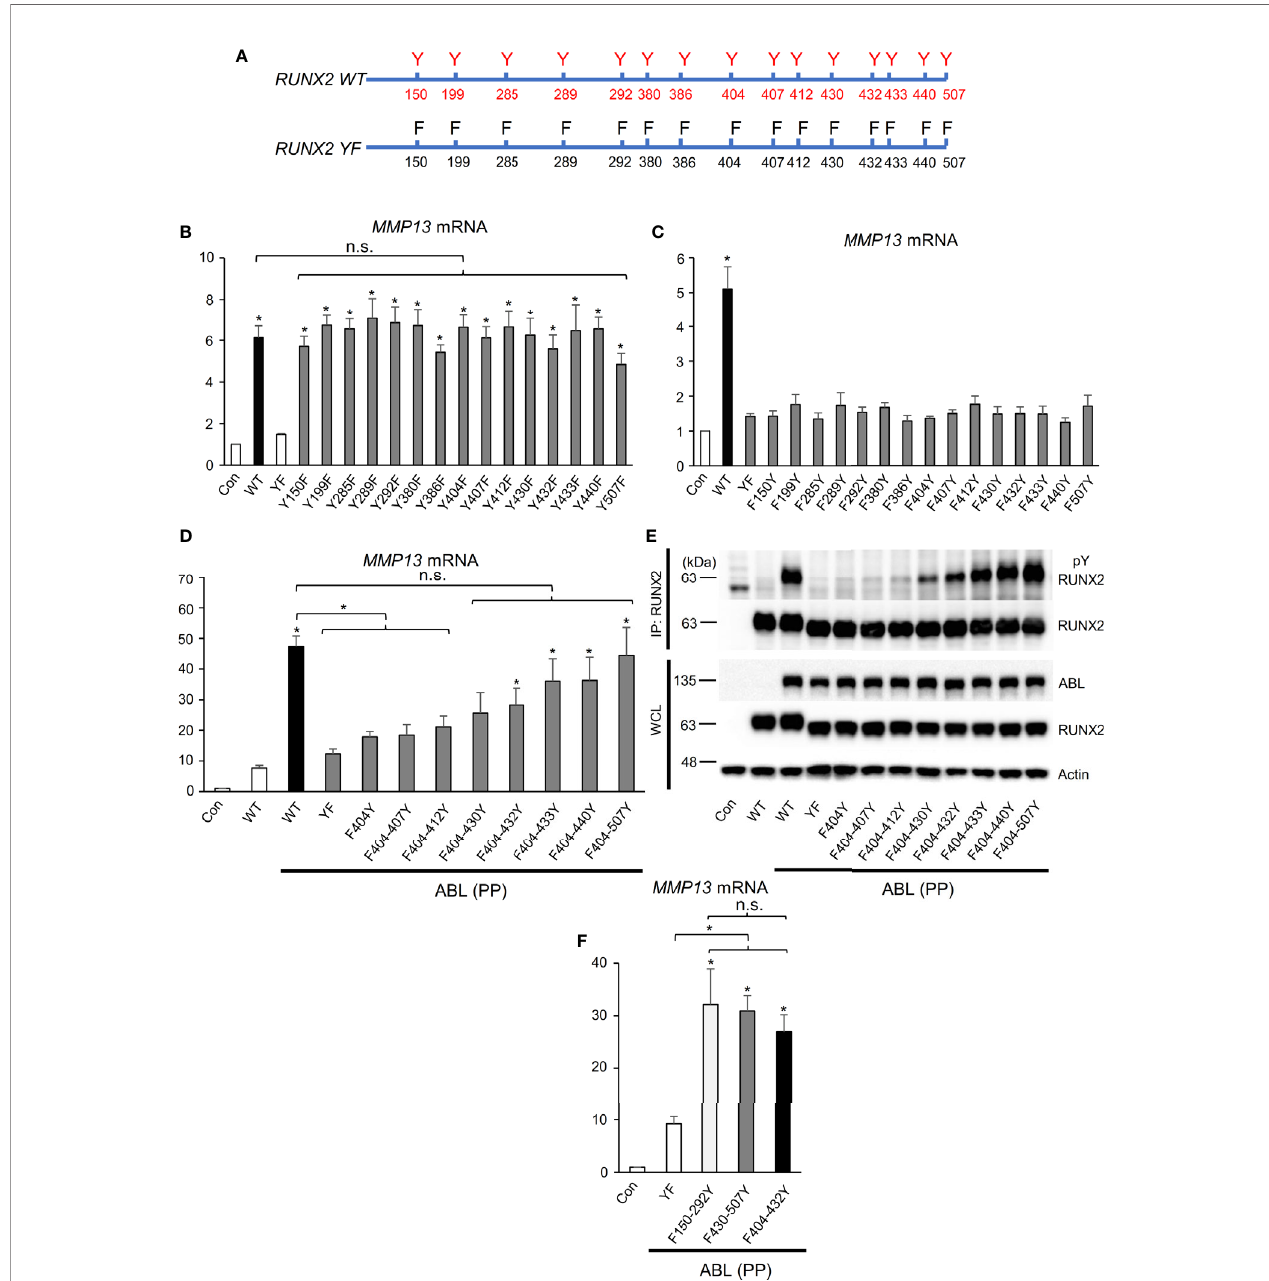
FIGURE 3 | RUNX2 transcriptional activity is dependent on the number of its tyrosine residues phosphorylated by ABL. (A) Schematic models of RUNX2 (WT) and RUNX2 (YF). (B – D, F) Quantitative PCR analysis of MMP13 mRNA expression in HEK293T cells co-transfected with the indicated constructs. n = 3. (E) HEK293T cells were co-transfected with the indicated constructs and RUNX2 immune complexes were probed with an anti-4G10 or anti-RUNX2 antibody. P values were determined by ANOVA with Tukey – Kramer ’ s post hoc test. Data are presented as means ± SEM. *P < 0.05. ns, no signi fi